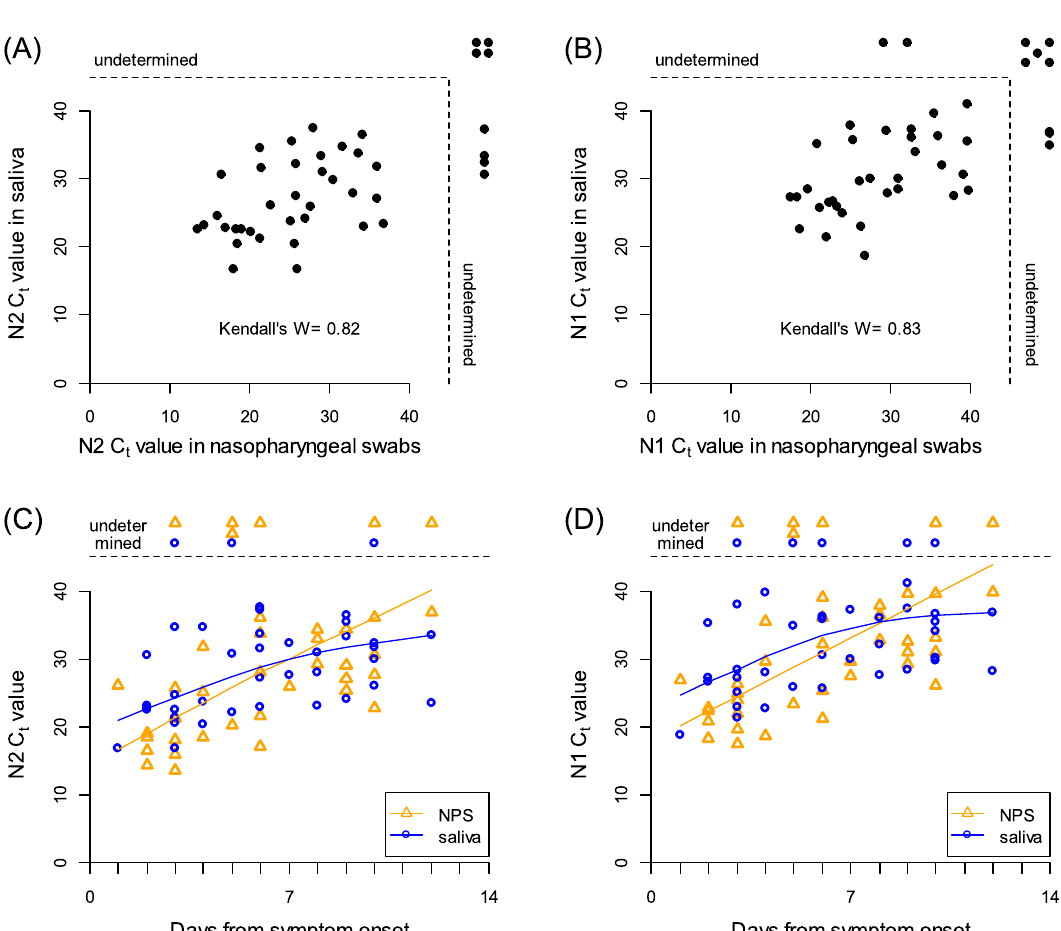
Figure 1. Viral loads of SARS-CoV-2 between nasopharyngeal swab and saliva specimens. (A,B) Scatter plots of Ct values using N2 (A) or N1 (B) primer and probe between NPS and saliva specimens taken from 42 COVID-19 patients. (C,D) Scatter plots of Ct values using N2 (C) or N1 (D) primer and probe primer against days from symptom onset. Median spline curves are also drawn using “qsreg” function with the default parameters in